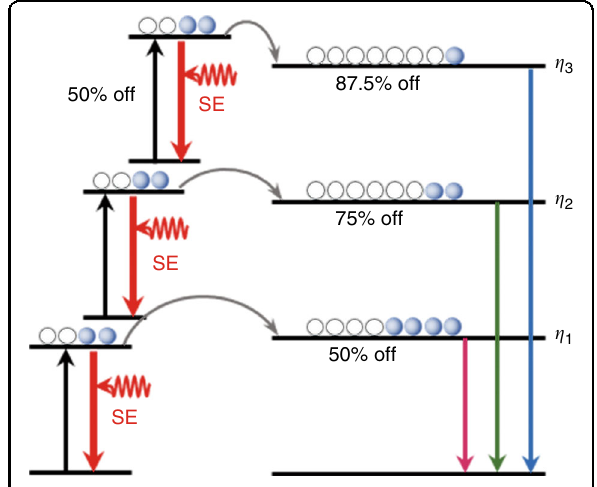
Fig. 2 Illustration of cascade ampli fi ed depletion